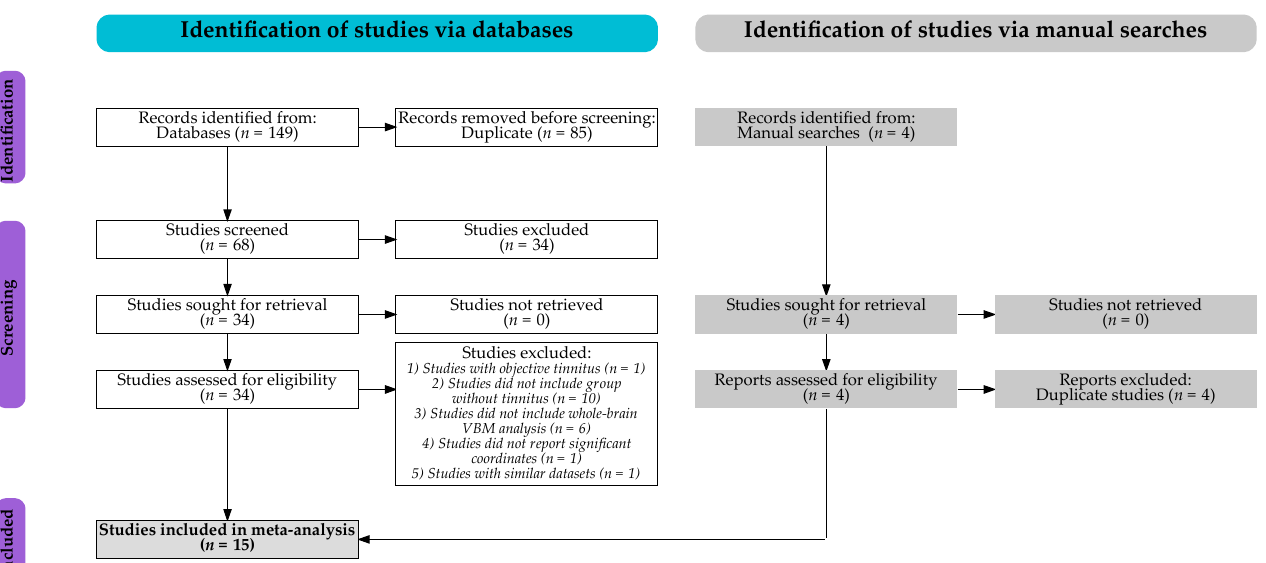
Figure 1. The PRISMA flowchart for studies included in the current meta-analysis.